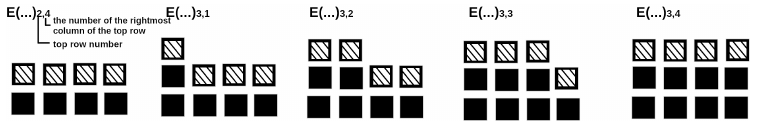
Figure 1. Notations for L x = 4 for different lengths of the top row filled in from left to right. The upper boundary is indicated by shaded